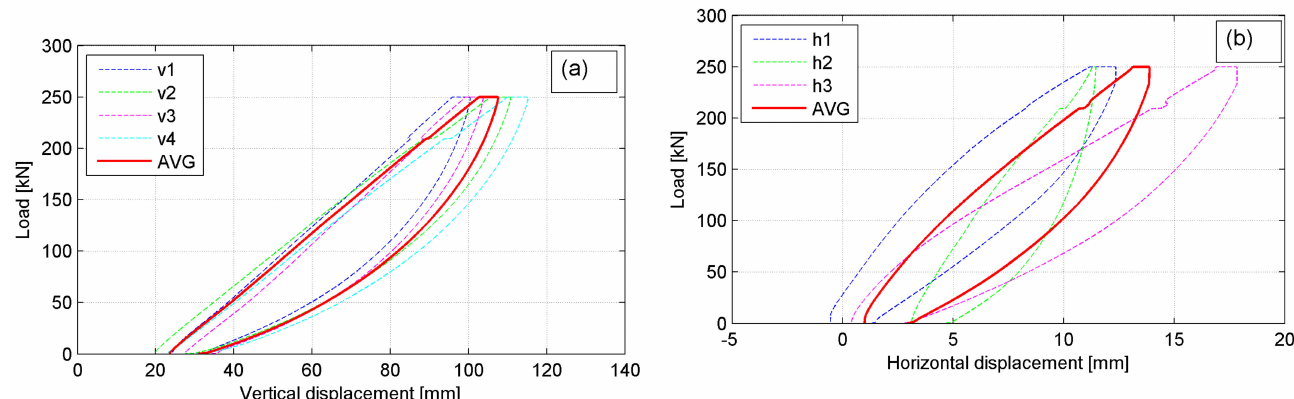
Figure 11. The behavior of P-4 bale under load p = 250 kN: ( a ) vertical displacements; ( b ) horizontal displacements.